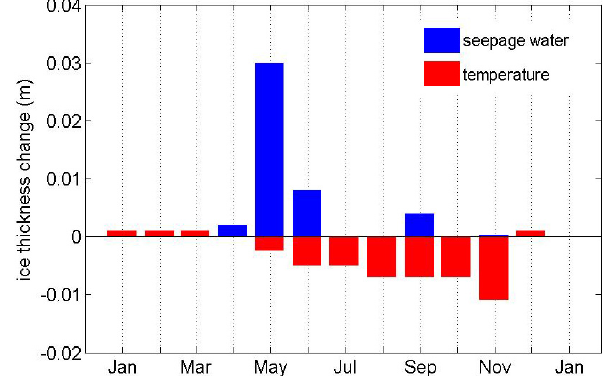
Fig. 9. Mean monthly sensitivity characteristics referring to increased temperature (+1 ◦ C) and input of seepage water (0.05mmh − 1 ) in respective months. The effect on the mass balance is calculated in terms of monthly changes in ice thickness relative to the reference